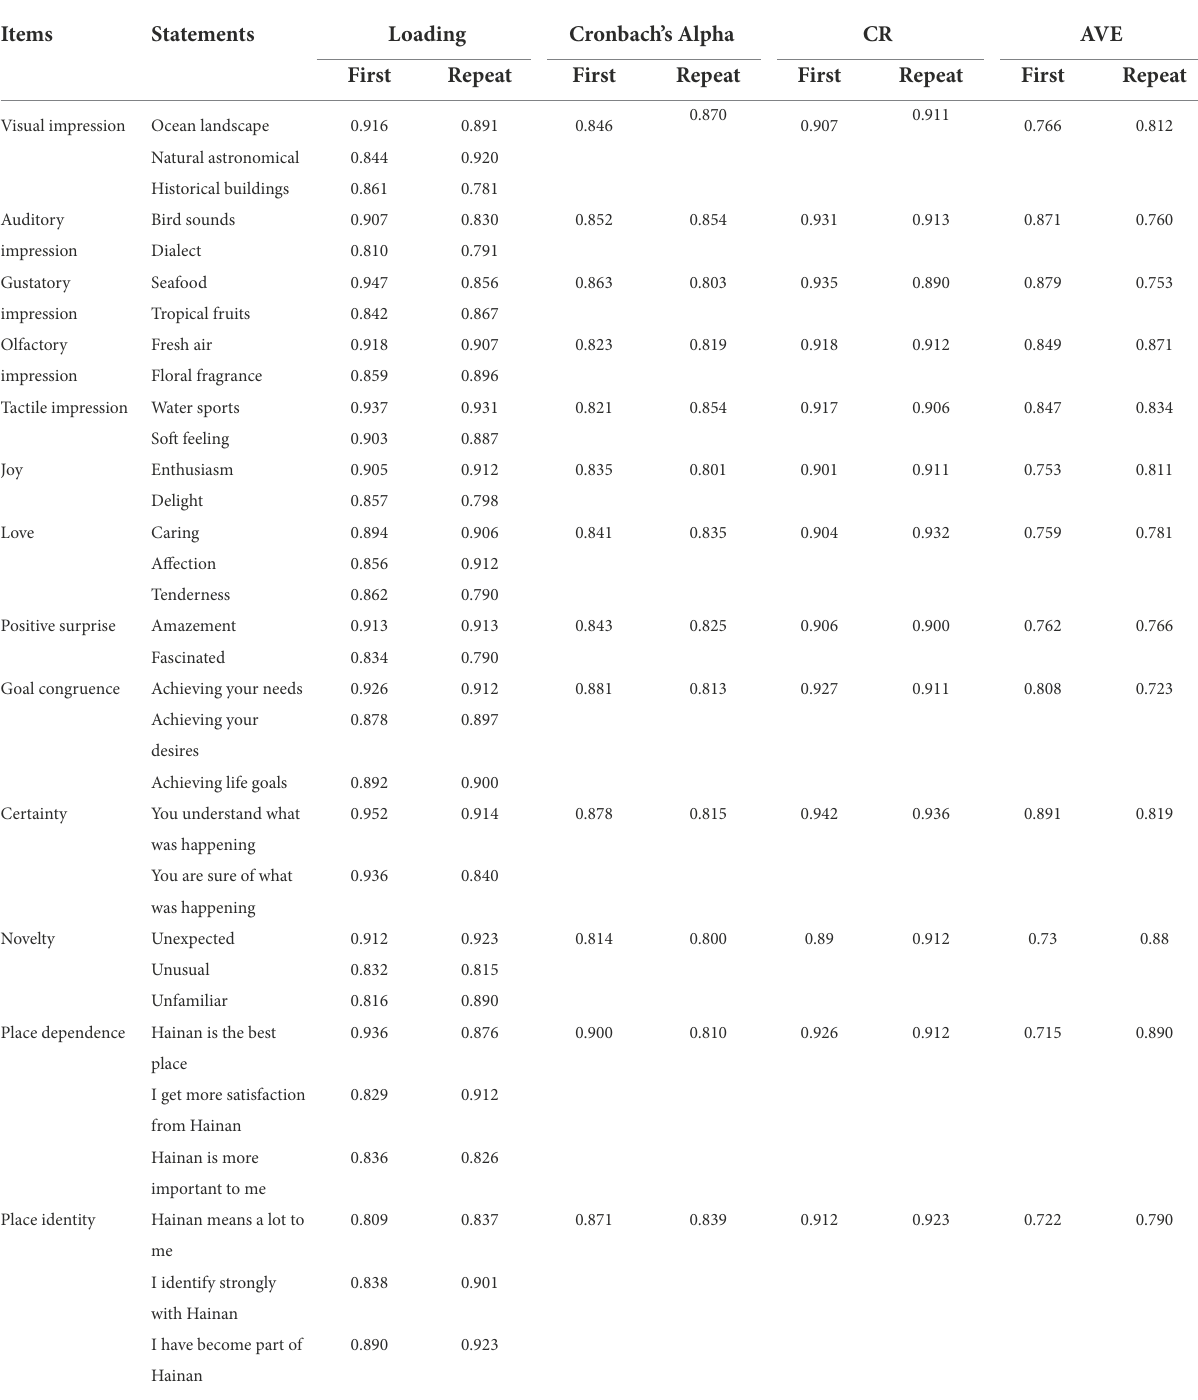
TABLE 1 Assessment results of the measurement